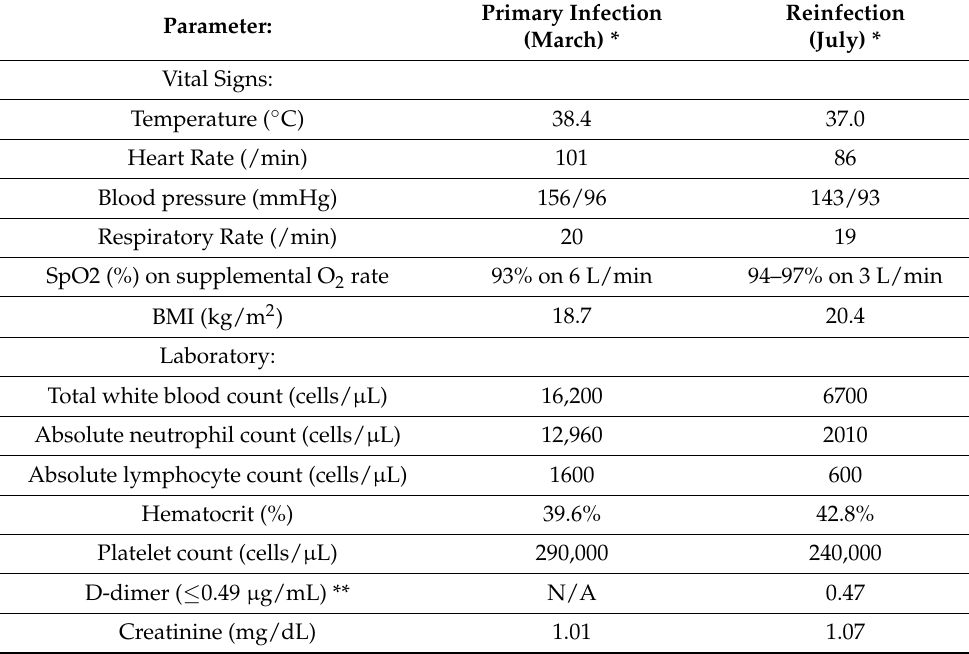
Table 1. Clinical Parameters at Peak Illness for COVID-19